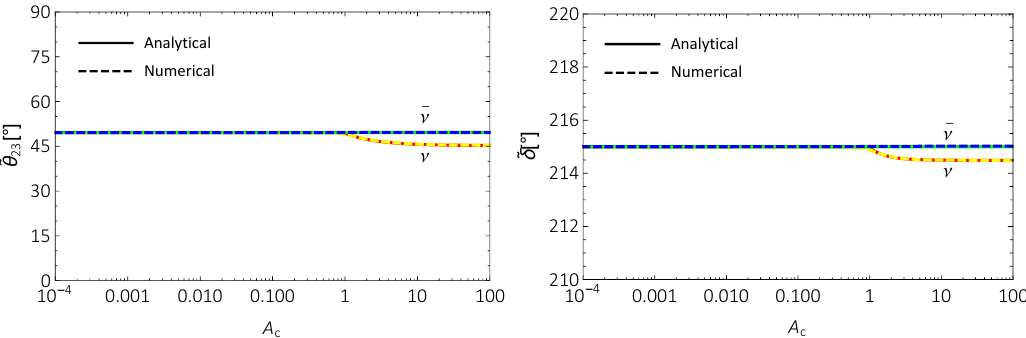
( left panel ) and e (cid:14) ( right panel ), where the 23